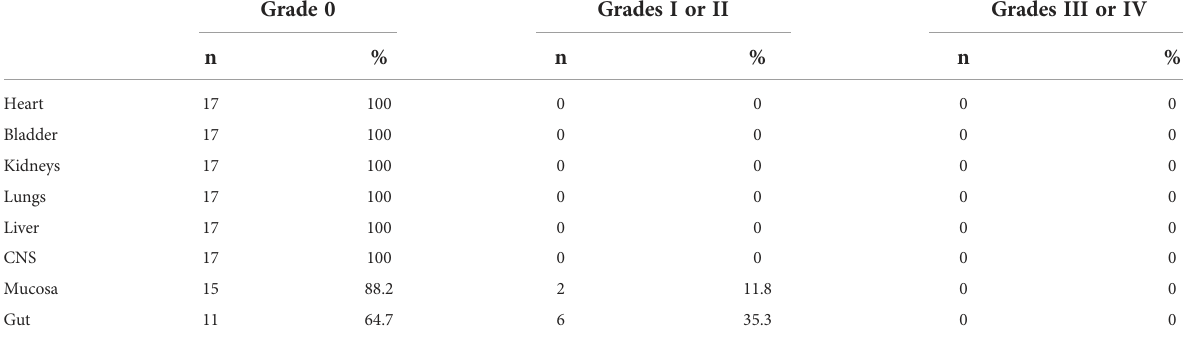
TABLE 3 Regimen-related toxicity according to organ system.